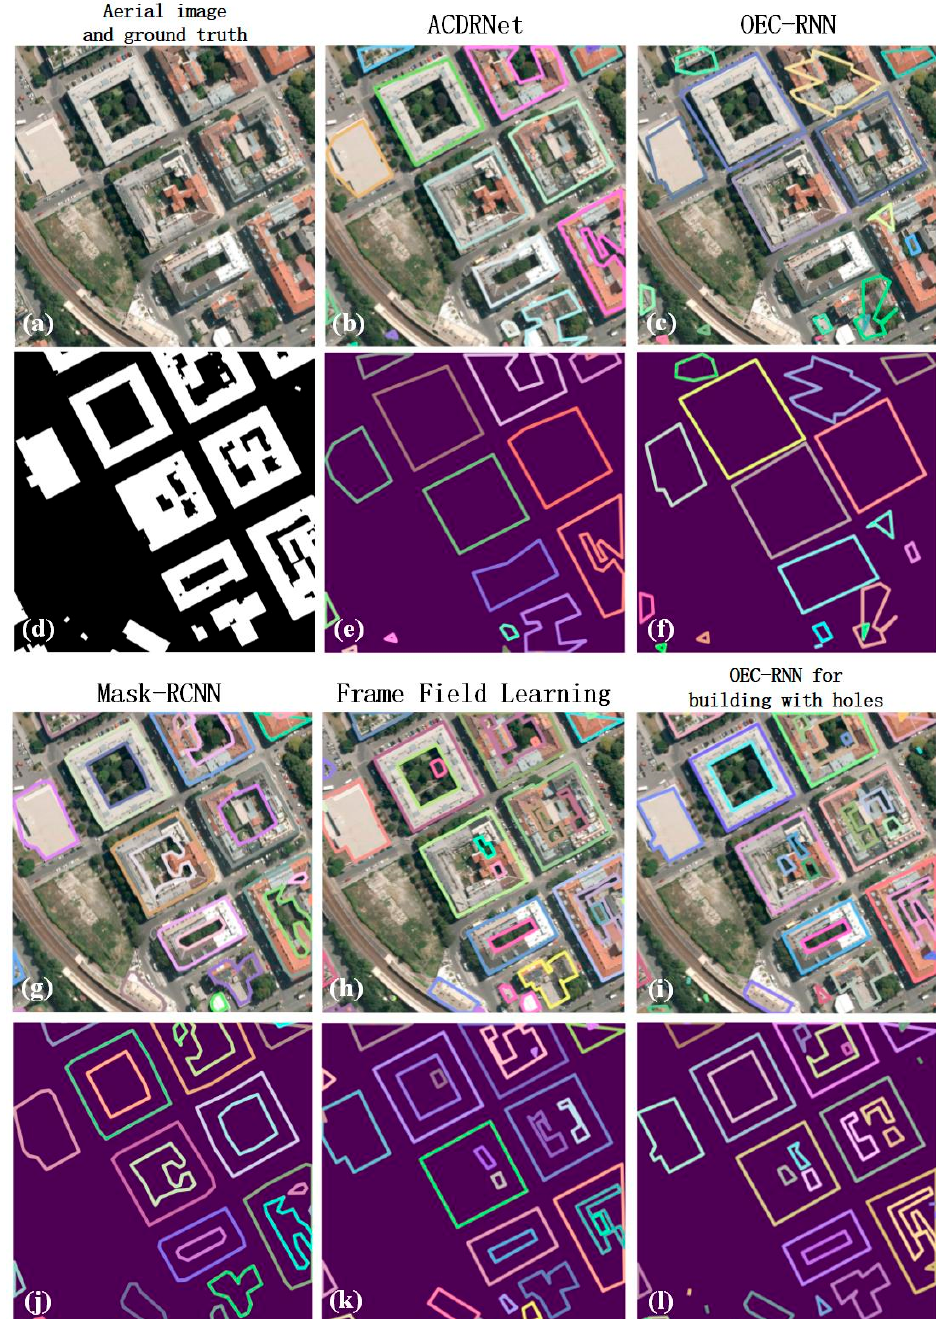
Figure 5. Qualitative comparison. These building instances are selected from Inria-vienna datasets: ( a ) original aerial image; ( d ) ground-truth. ( b , c , g , h , i ) are results with aerial images of ACDRNet, OEC-RNN, Mask R-CNN, frame field learning and OEC-RNN for buildings with holes, respectively. ( e , f , j , k , l ) are the results with a pure-color background.